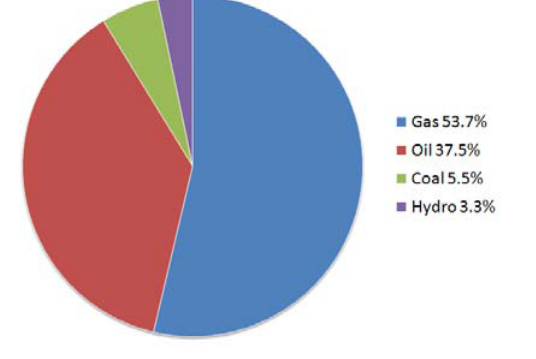
Figure 1. Energy sources diversity in electricity generation in the Middle East.